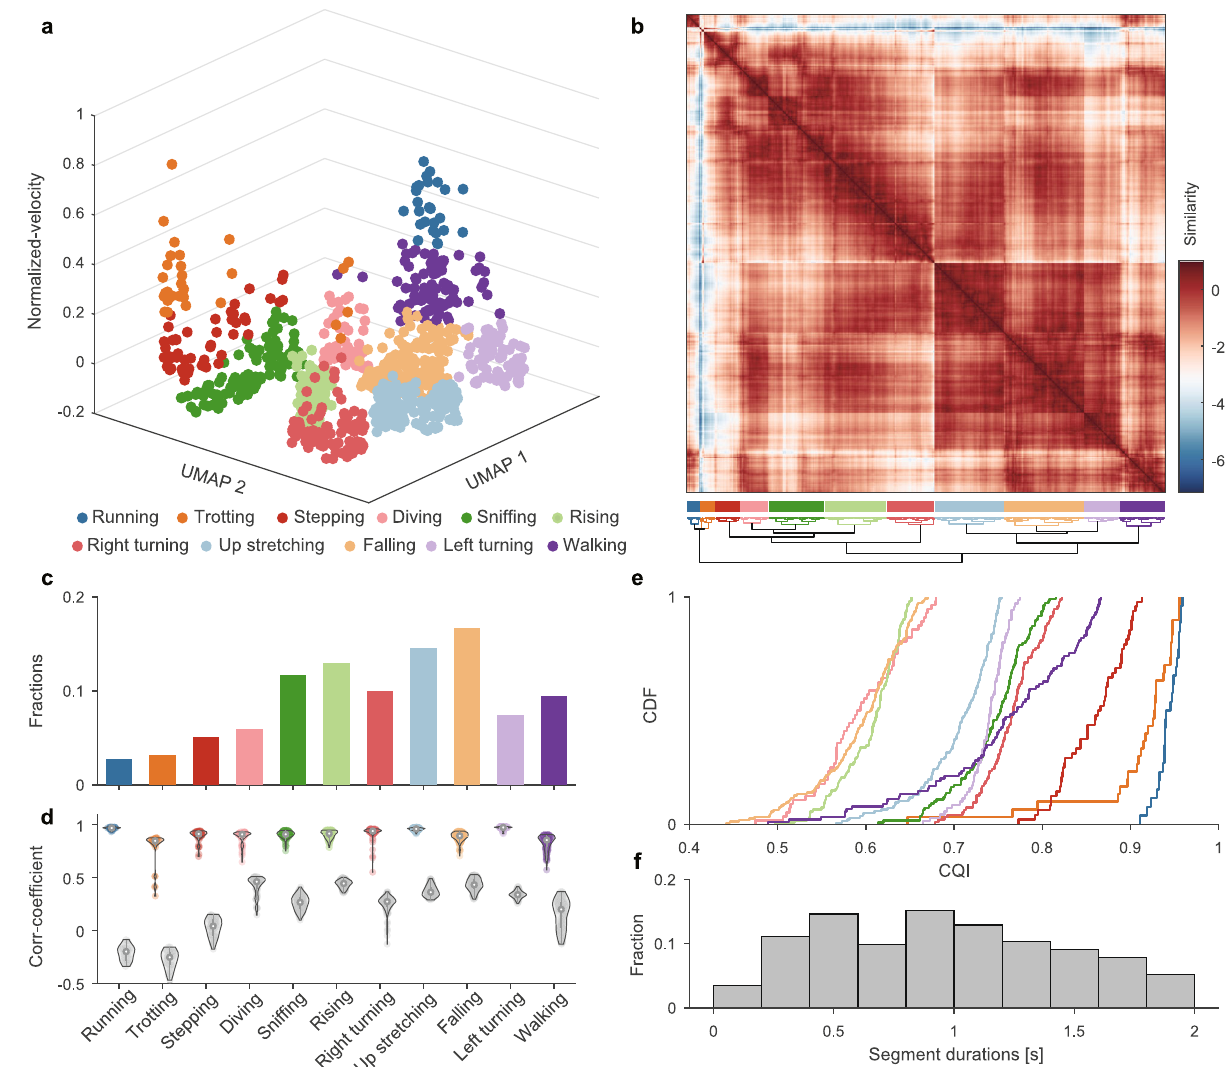
Fig. 4 Identify movement phenotypes on single experimental data. a Spatiotemporal feature space of behavioral components. Each dot on the 3D scatter plot represents a movement bout ( n = 935 bouts). The 11 different colors indicate the corresponding to 11 movement types. b Upper, recalculated paired- wise similarity matrix, and they were rearranged with a dendrogram (lower). Each pixel on the matrix represents the normalized similarity value of a pair of movement bouts at the i th row and the j th column. The color-coded bars indicate the labels of clustered movement (middle). c Fractions of movement bouts number. For each subject, the behavior fractions are de fi ned as the bouts number of each behavioral phenotype divide by the total number of behavior bouts the animal occurred during the experiment. d Intra-CC (color-coded) and inter-CC (gray dots) of each movement group. The dots on each violin plot represents their intra-CC or inter-CC, and dots number in a pair of violin plot in each group are the same (Intra-CC: 0.91 ± 0.07; Inter-CC: 0.29 ± 0.19). e Cumulative Distribution Function (CDF) of CQI of the movement clusters. The clusters represented by the curves on the right side have better clustering qualities, and their corresponding movements are more stereotyped. f The histogram of the duration of all movements (0.963± 0.497s). CC correlation coef fi cient, CDF cumulative distribution function, CQI Clustering Quality Index. Source data are provided as a Source Data fi